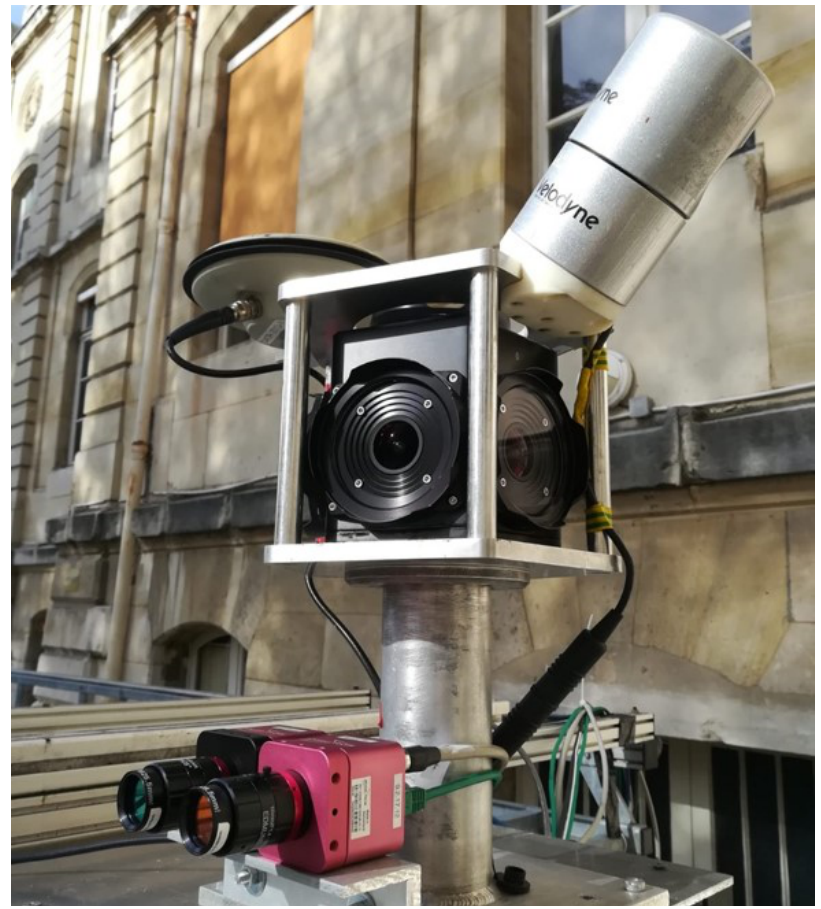
Figure 1. Prototype acquisition system used to create the PC3D dataset in the city of Paris. Sensors: Velodyne HDL32 LiDAR, Ladybug5 360° camera, Photonfocus MV1 16-band VIR and 25-band NIR hyperspectral cameras (hyperspectral data are not available in this dataset; they cannot be used in mobile mapping due to the limited exposure